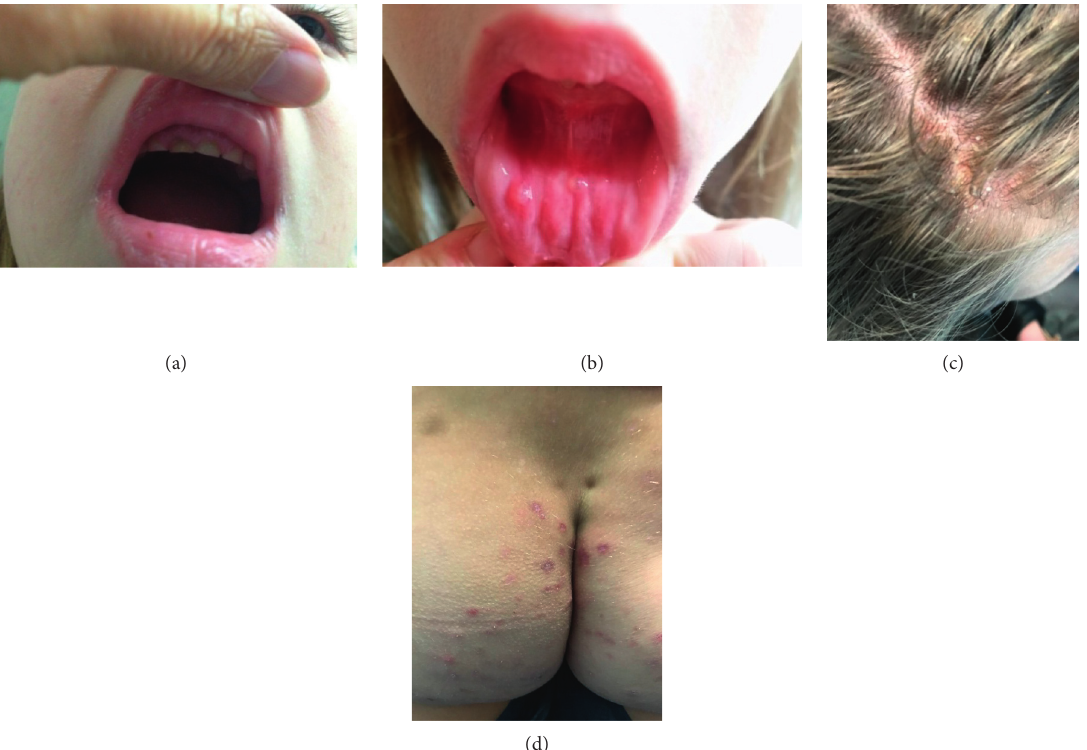
Figure 2: Data of some physical manifestations of Patient 2. (a) Hypoplasia of upper teeth at 7 years. (b) Recurrent oral ulcers at 7 years. (c) Resistant to treatment dermatitis to the scalp. (d) Resistant to treatment dermatitis of the gluteal